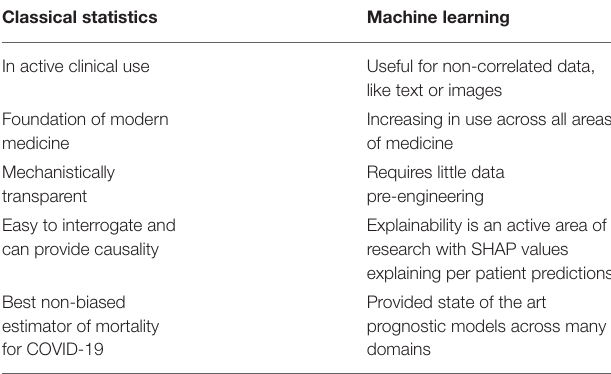
Table 1 | Uses and strengths of classical statistics vs. machine learning in COVID-19 prognostic